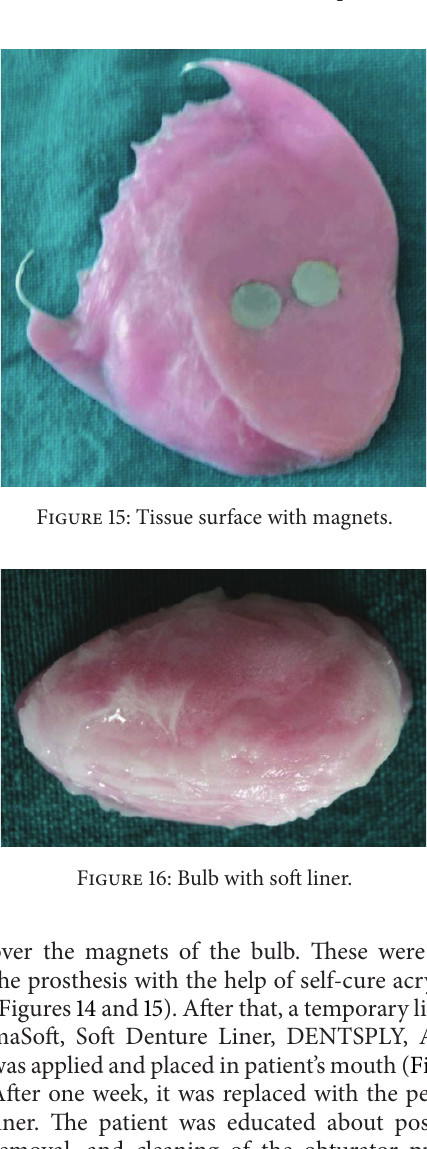
Figure 13: Bulb in patient’s mouth.